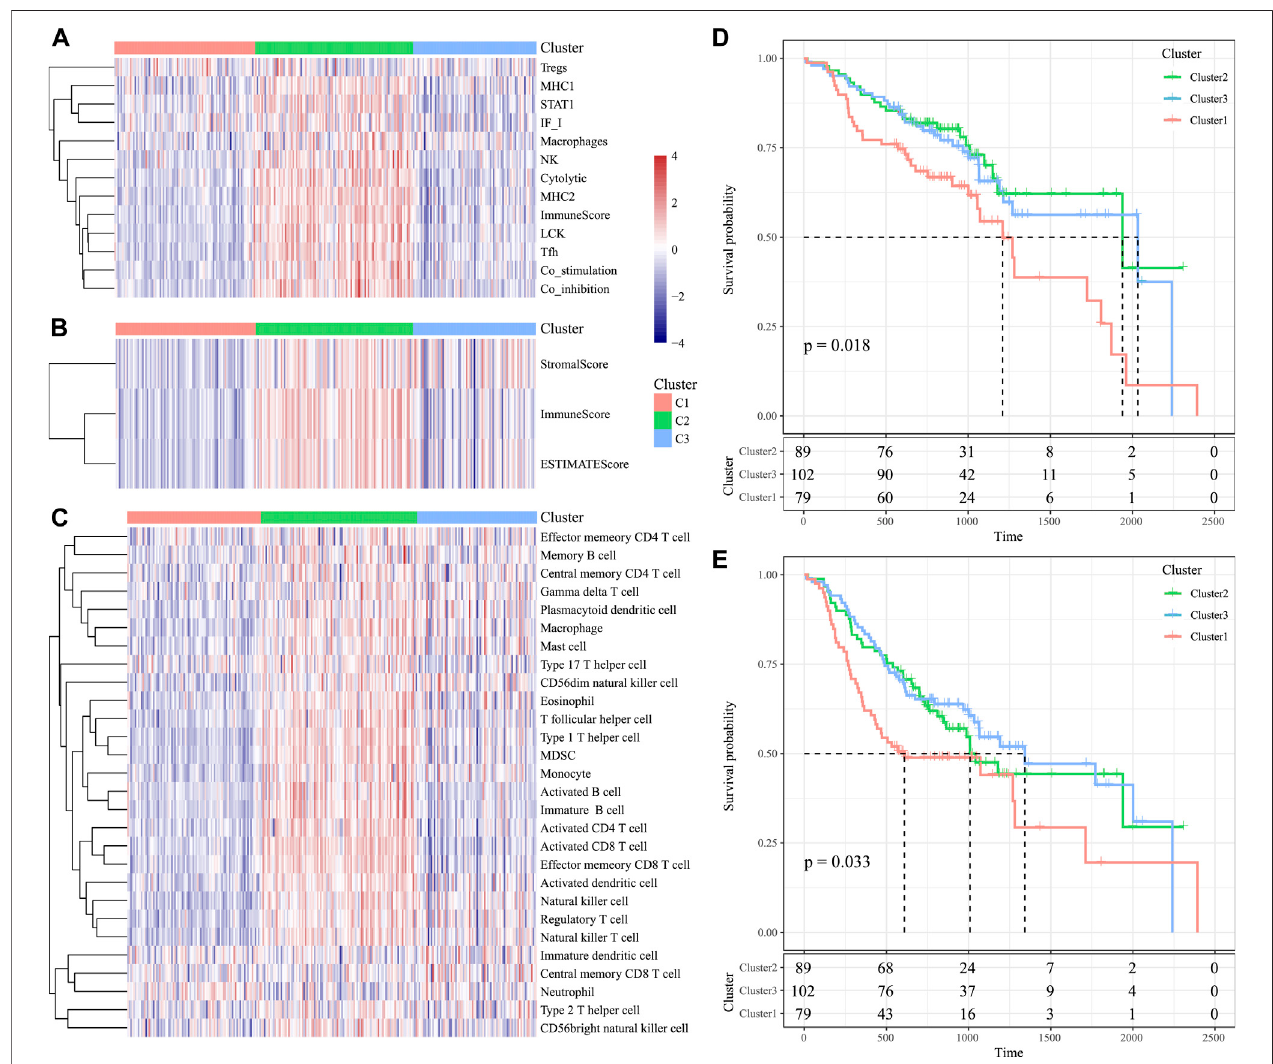
FIGURE9| Immune pro fi lesandsurvivalanalysisofthreeHNSCC subtypesinthevalidationset. (A) Scoresof13typesofimmunemetagenesinthethreeHNSCC subtypesaredisplayed. (B) Tumorstromascores,theimmunescores,andtheESTIMATEscoresinthethreeHNSCCsubtypesaredisplayed. (C) Scoresof28immune- related pathways across the three HNSCC subtypes are shown. (D) KM curve of OS prognosis of three subtypes. (E) KM curve of PFS prognosis of three subtypes.